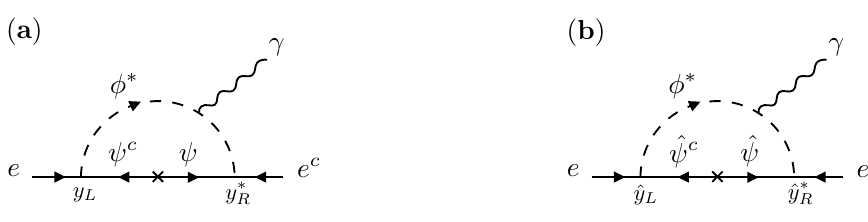
Figure 2 . One-loop diagrams contributing to the electromagnetic dipole moments of a charged Dirac fermion in the model of eq. (3.1). (a) and (b) feature a Dirac fermion with mass m and ˆ m respectively propagating inside the loop. For m 2 = 0 , the amplitude is of the form given in eq. φ